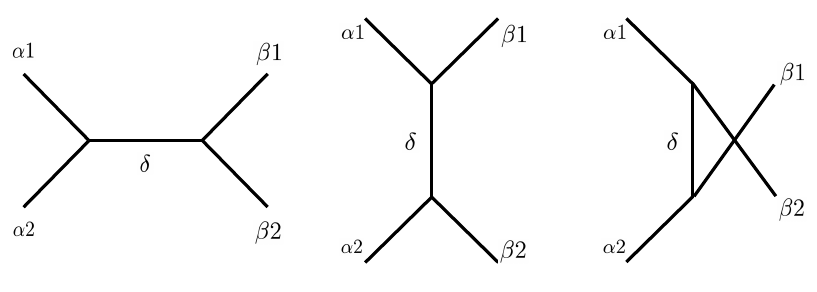
Figure 1 . Tree-level diagrams. Particles α 1 , α 2 , β 1 , β 2 and δ can be scalar or